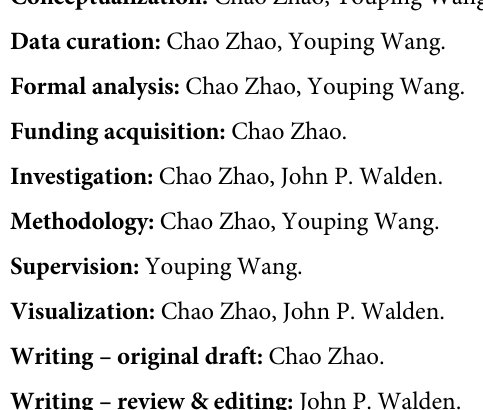
S1 Table. The geographical coordinates, dating, and types of lithic technology of the sites discussed in the paper. The radiocarbon dates are calibrated by using OxCal 4.4 and the IntCal20 calibration curve. The references of the dating for each site are listed in S1 File. (XLSX) S1 File. The bibliography of the sites discussed in the paper. The dating information and the identification of the types of lithic technology for each site discussed in the paper are based upon the references listed in this